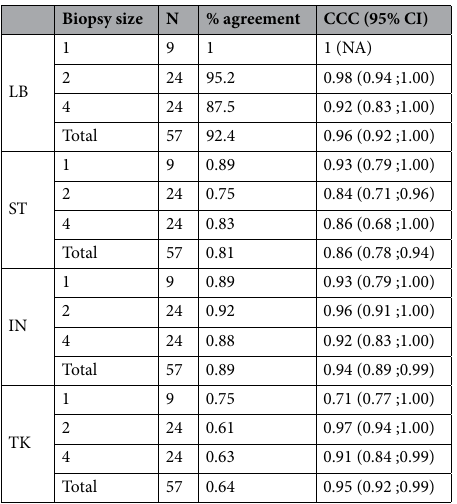
Table 2. Subscales and total Krenn scoring system interobserver agreement and according to size of biopsy forceps. LB = lining layers ; ST = stroma cells ; IN = inflammatory infiltrate ; TK = total Krenn ; NA = no available. CCC = concordance correlation coefficient ; N = number of